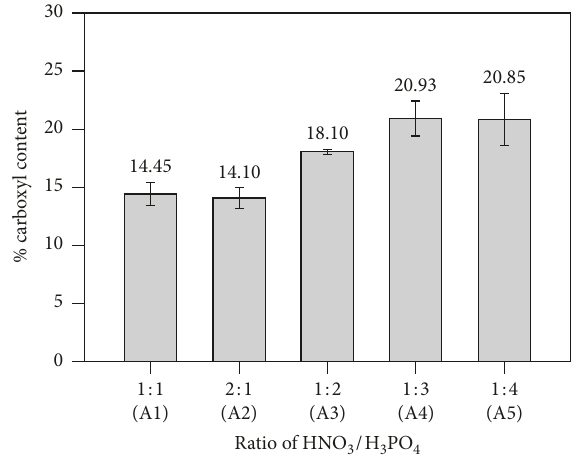
Figure 5: Effect of temperature on the carboxyl content of the OC. 3 /H 3 PO 4 on the carboxyl 1 :3 of acid mixture and 1.4% The reaction using HNO 3 /H 3 PO 4 (cid:31) (w/v) of NaNO 2 for 24